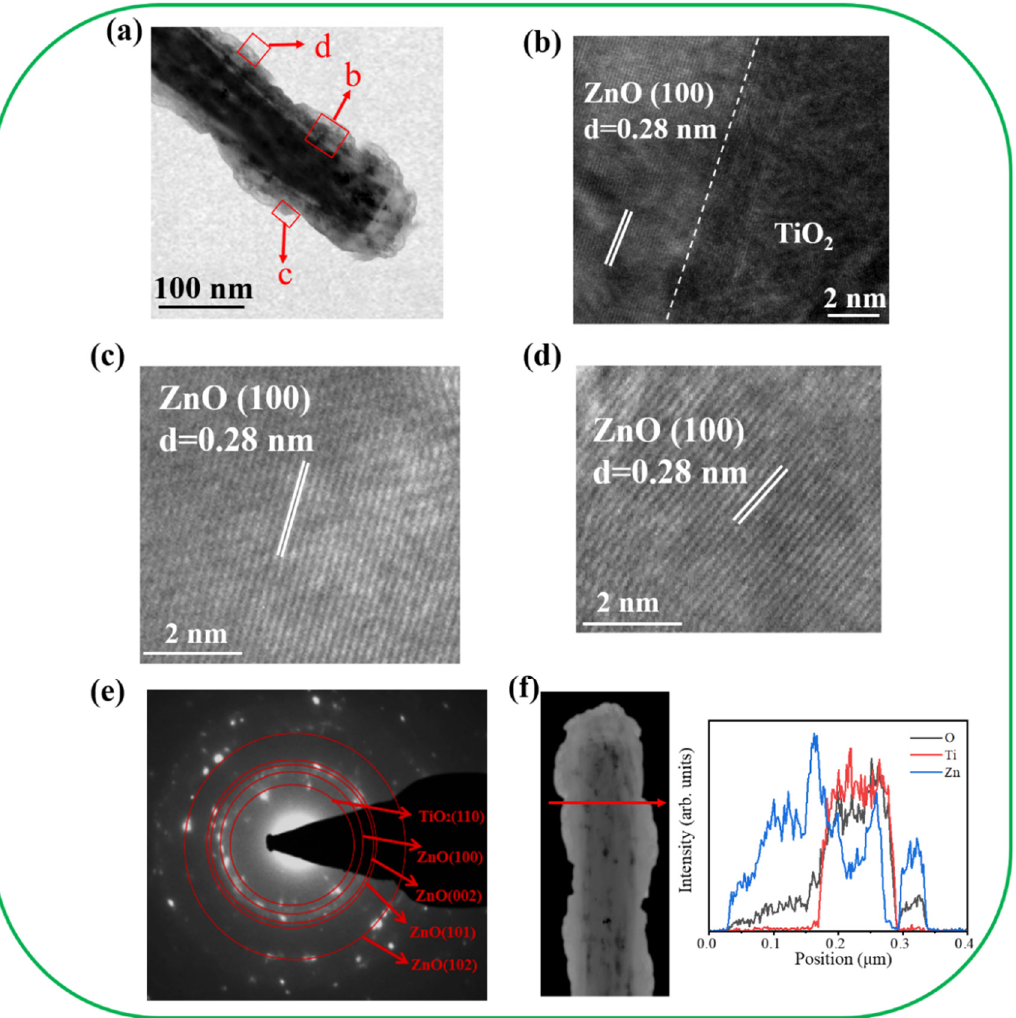
Figure 5. TEM analyses of TiO 2 –ZnO–H ( a ) Low-magnification TEM image. ( b – d ) HRTEM images taken from various regions of the sample. ( e ) SAED pattern of several composite nanostructures. ( f ) EDS line-scanning profiles across the sample.